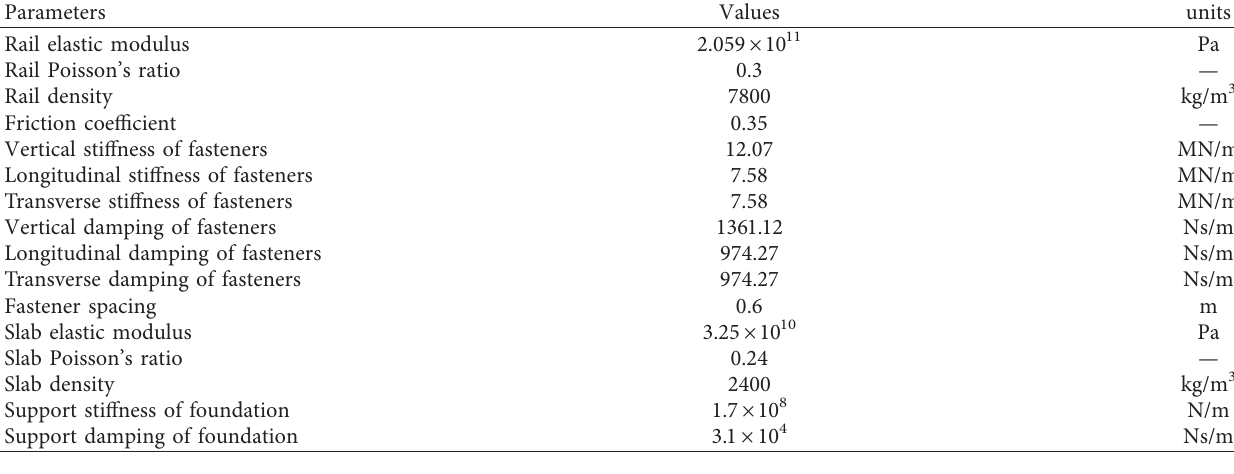
Table 3: Track structure parameters.